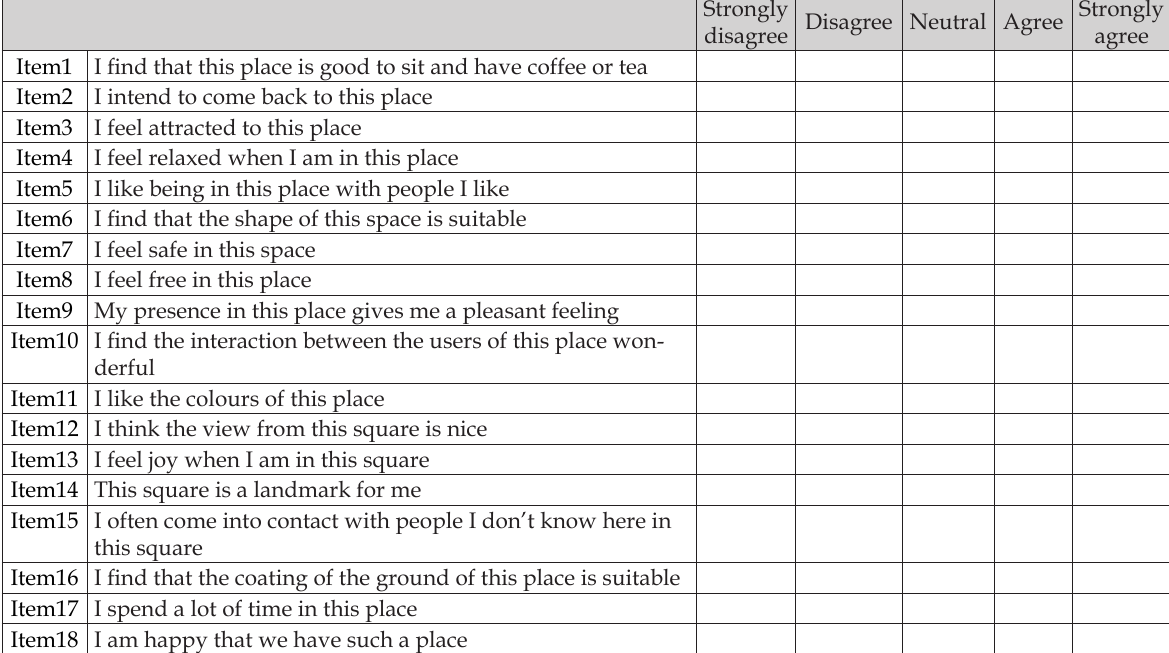
Table A. Questionnaire on the experiential of Algerian public places (English version).